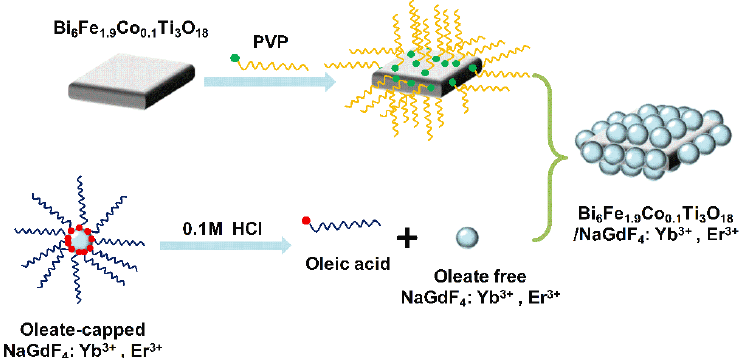
Figure 1. The schematic representation of synthesizing Bi 6 Fe 1.9 Co 0.1 Ti 3 O 18 /NaGdF 4 :Yb 3+ , Er 3+ (BFCTO/NGF) nanocomposites.